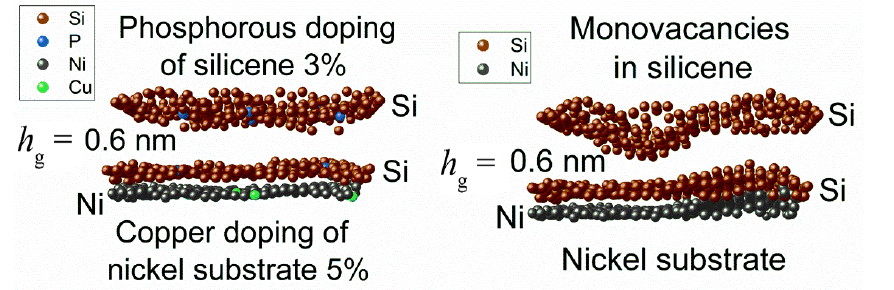
Figure 12. zx-projections of the silicene channel (doped with phosphorous or modified with vacan- cies) and the top sheet of the Ni(111) substrate. Adopted with permission from Ref. [39]. 2021, Else-